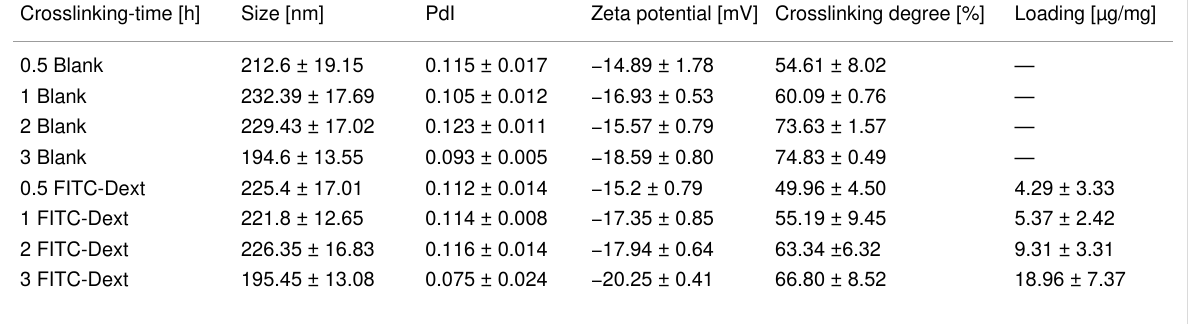
Table 1. Particle imaging in the QI™-mode allowed to extract the height image from the force–distance curves acquired at each pixel. Particles were well distributed on substrates showing no agglomeration and a narrow size distribution.